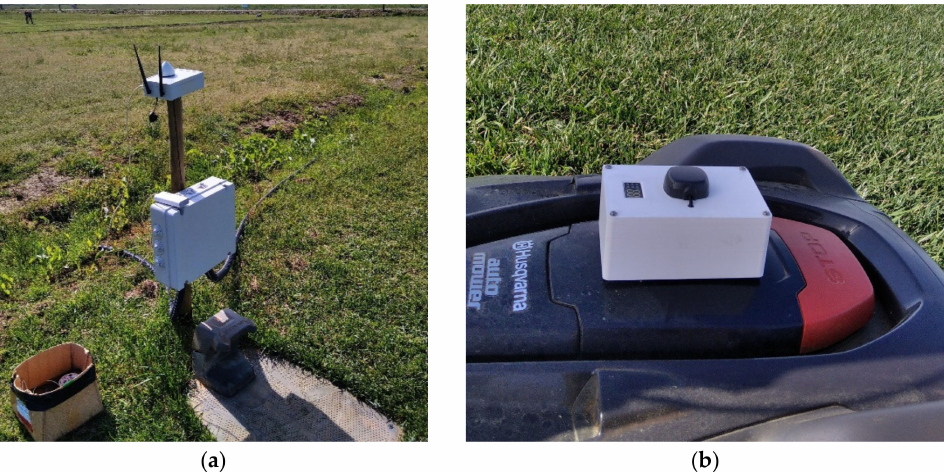
Figure 1. Details of the remote sensing system consisting of the two RTK-GPS devices: ( a ) the base station on the side of the studied area; ( b ) the rover installed on the autonomous